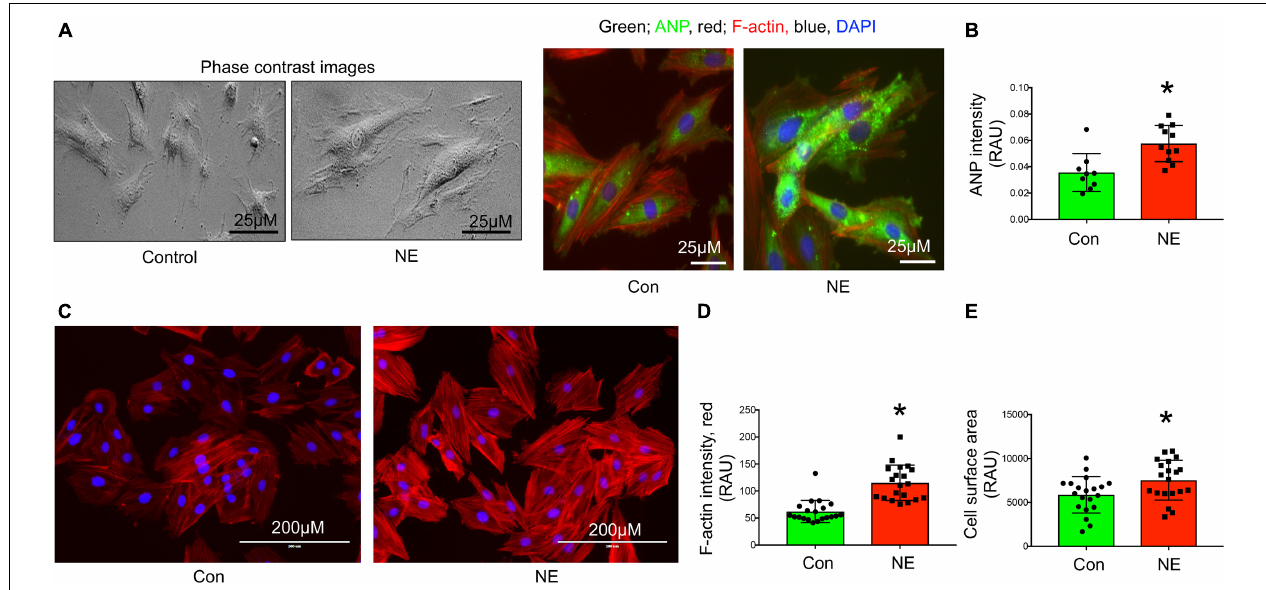
FIGURE 5 | Norepinephrine induced hypertrophy in H9c2 rat cardiomyocytes. (A) Representative phase contrast and immunocytochemistry images showing cardiomyocyte hypertrophy marker ANP localization in control and NE-treated H9c2 cardiomyocytes. (B) Bargraph showing quantification of ANP intensity (green), n = 10 cells per group, dot represent individual cell intensity from three independent experimental groups. (C) Representative images showing F-actin staining using Alexa R (cid:13) Fluor 594 Phalloidin conjugate dye of control and NE-treated H9c2 cardiomyocytes. Red, F-actin; blue, DAPI stained nucleus. (D) Bargraph showing quantification of F-actin intensity and (E) cell surface area measurement in control and NE-treated H9c2 cardiomyocytes, n = 20 cells per group, dot represent individual cells intensity or area from three independent experimental groups. Data are presented as mean ± SEM. * P -values < 0.05 considered as significant, Student’s t -test.